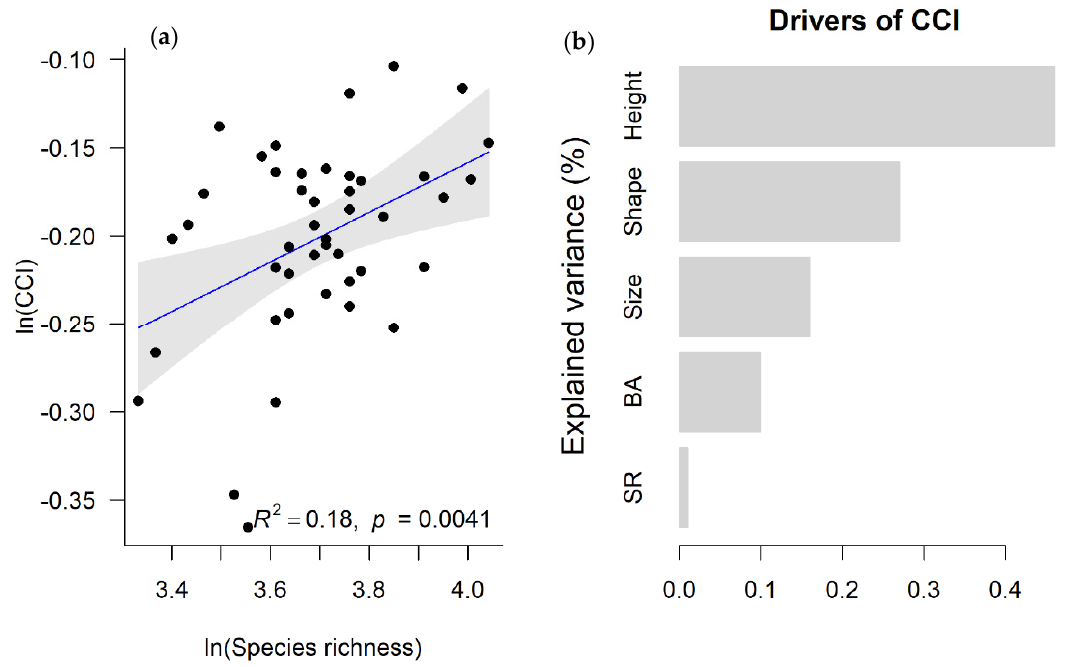
Figure 1. Species richness and crown spatial complementarity. ( a ) Bivariate relationship between species richness and crown spatial complementarity; and ( b ) relative contributions of drivers on crown spatial complementarity. Table 1. Characteristic of stand variables in this subtropical forest. Values are mean value and its ranges for each